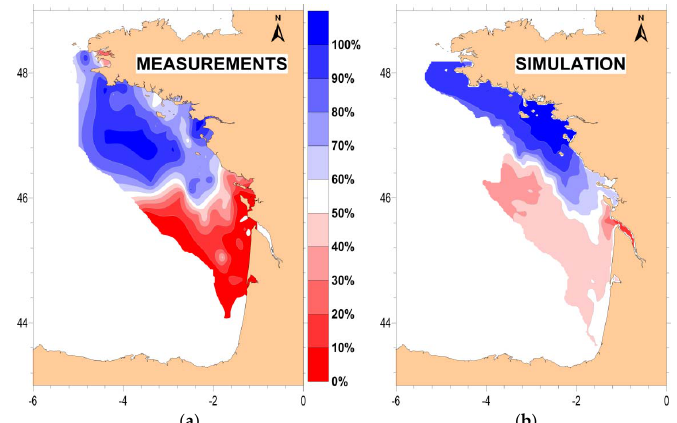
Figure 12. ( a ) Measured and ( b ) simulated freshwater contribution of the Loire River relatively to the Gironde River, adapted from [26] in spring 2016.